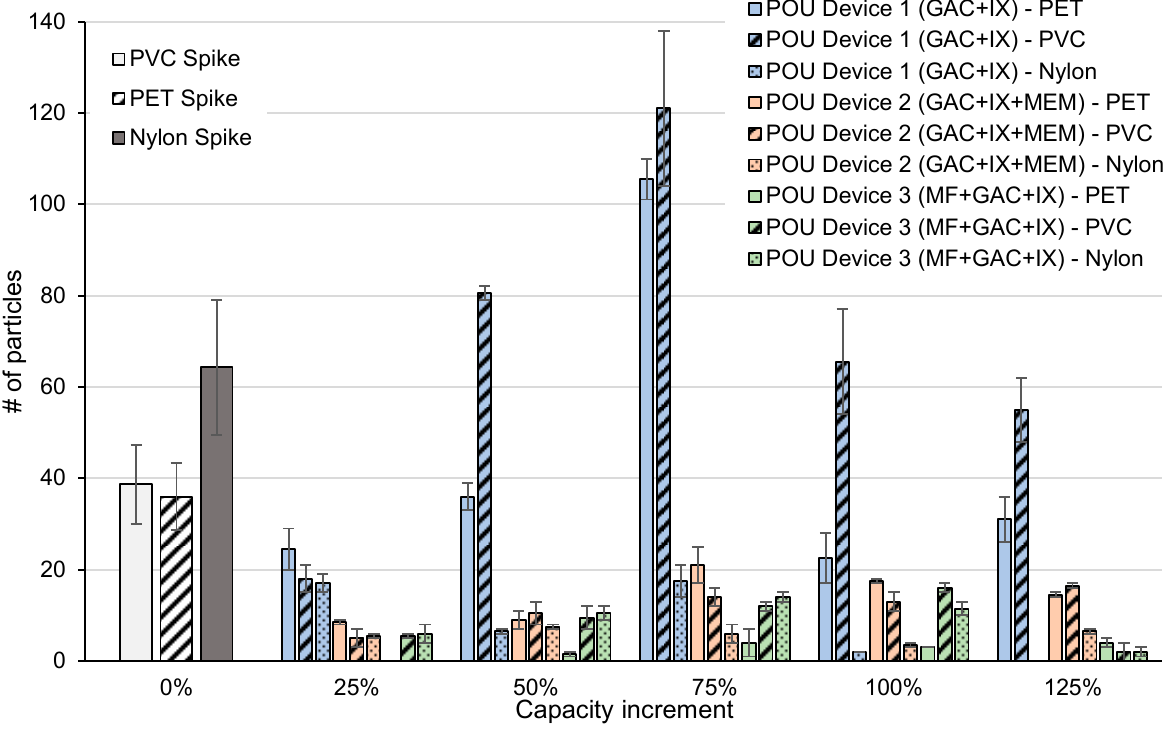
Figure 3. Mean microplastic particles or fibers in POU effluent as a function of rated treatment capacity. Vertical bars represent ± one standard deviation ( n = 2).